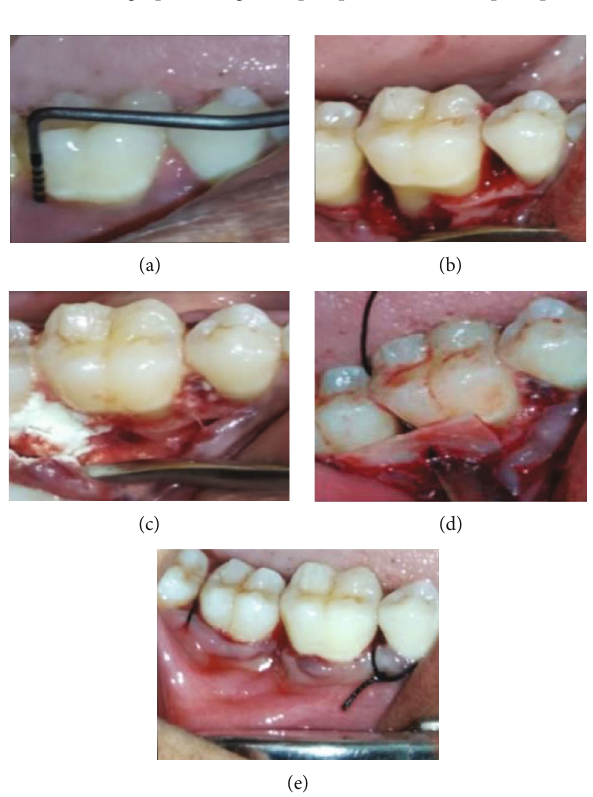
Figure 2: (a) PPD-10 mm. (b) Debridement done. (c) Placement of bovine colostrum. (d) GTR placement — suturing